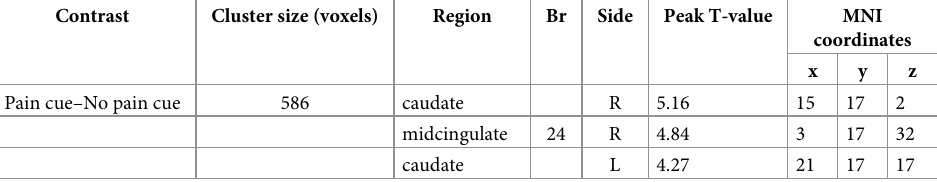
Note: Cluster-level familywise error rate of p < 0.05. R: right; L: left; NA: coordinates are not in the AAL.